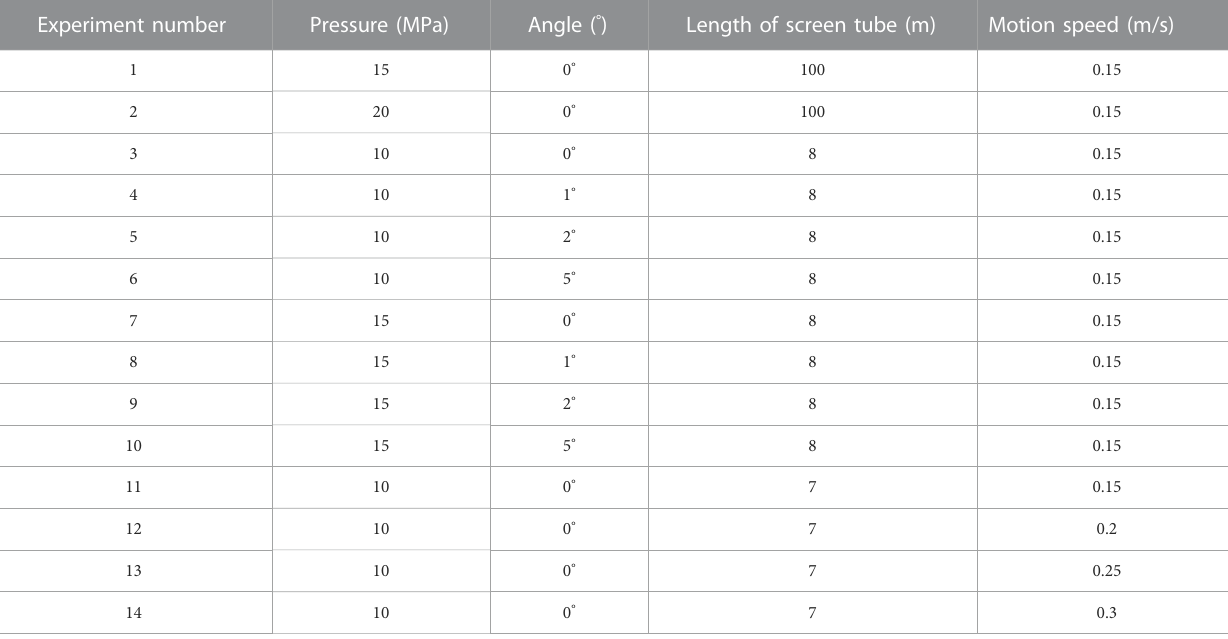
TABLE 1 Experimental scheme for system resistance testing.